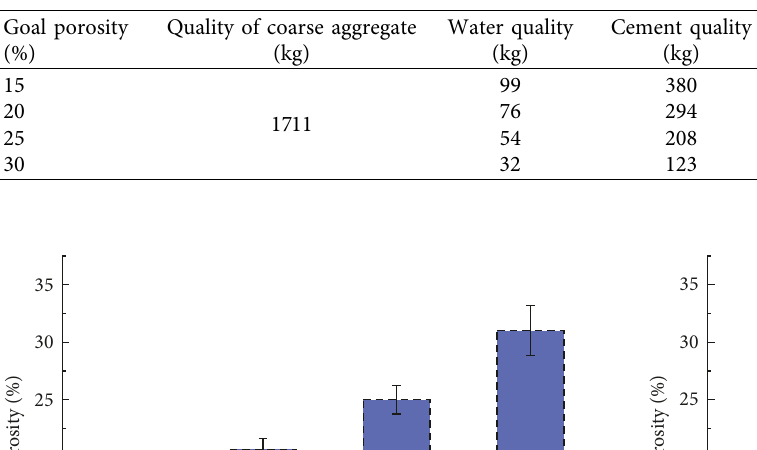
Table 6: The result of design of mix proportion of porous concrete (per cubic meter).